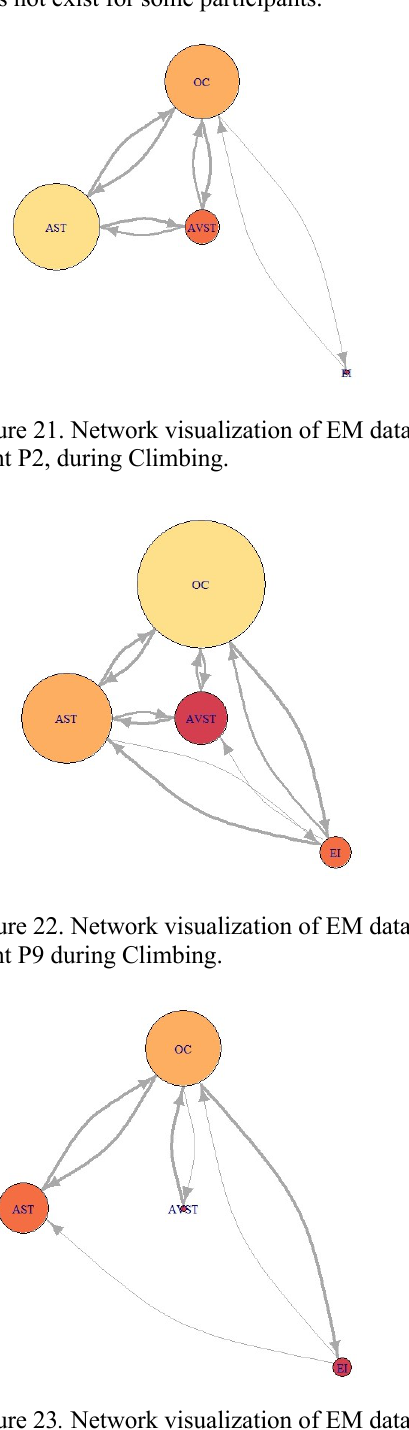
Figure 23 . Network visualization of EM data for partic- ipant P8 during Climbing